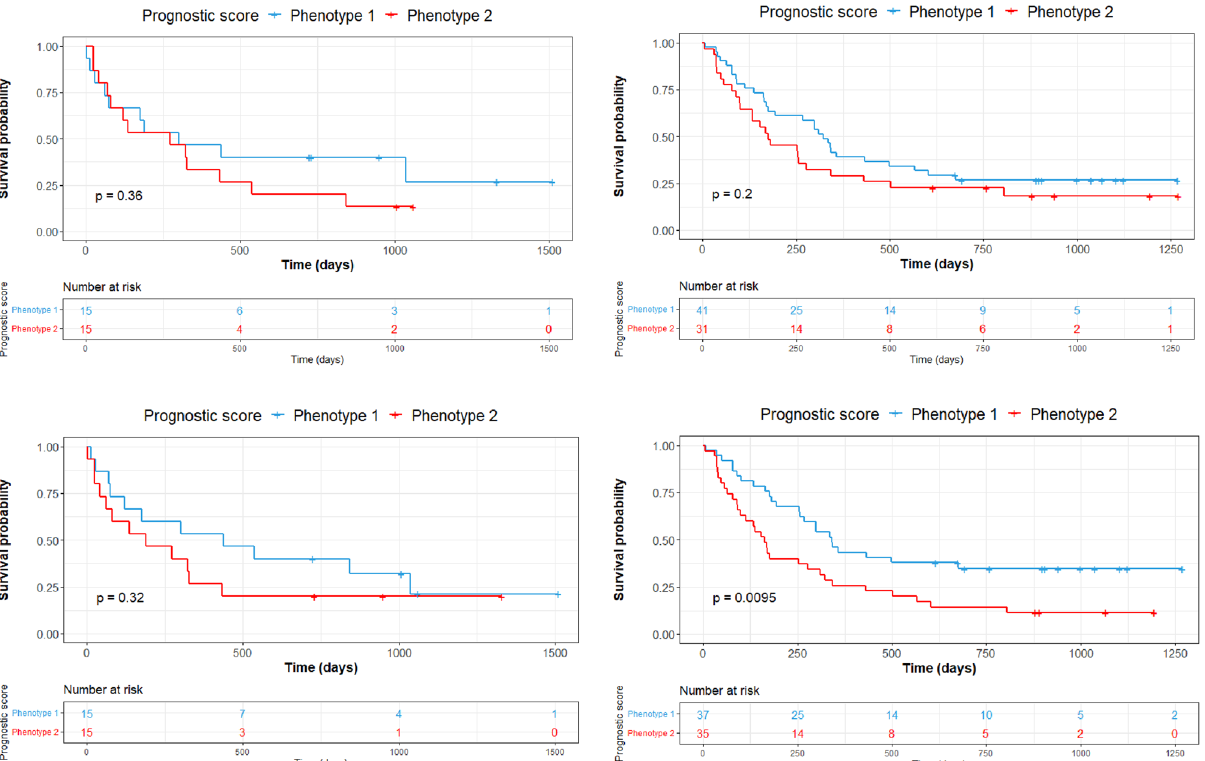
Figure 4. Survival analysis by line of therapy. Progression-free survival for the model built using radiomic phenotypes of patients treated with monotherapy (top left), the model built using radiomic phenotypes of patients treated with combination therapy (top right), multivariable model built using clinical covariates (PDL1 expression, ECOG, BMI and smoking status) and radiomic phenotypes of patients treated with monotherapy (bottom left) and multivariable model built using clinical covariates and radiomic phenotypes of patients treated with combination therapy (bottom